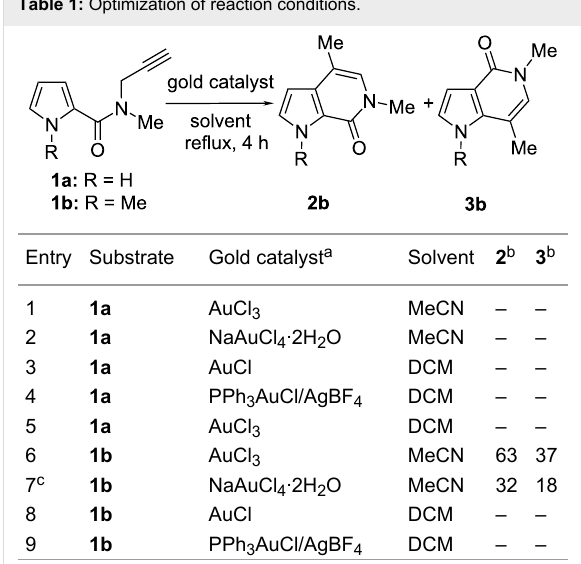
Table 1: Optimization of reaction conditions.